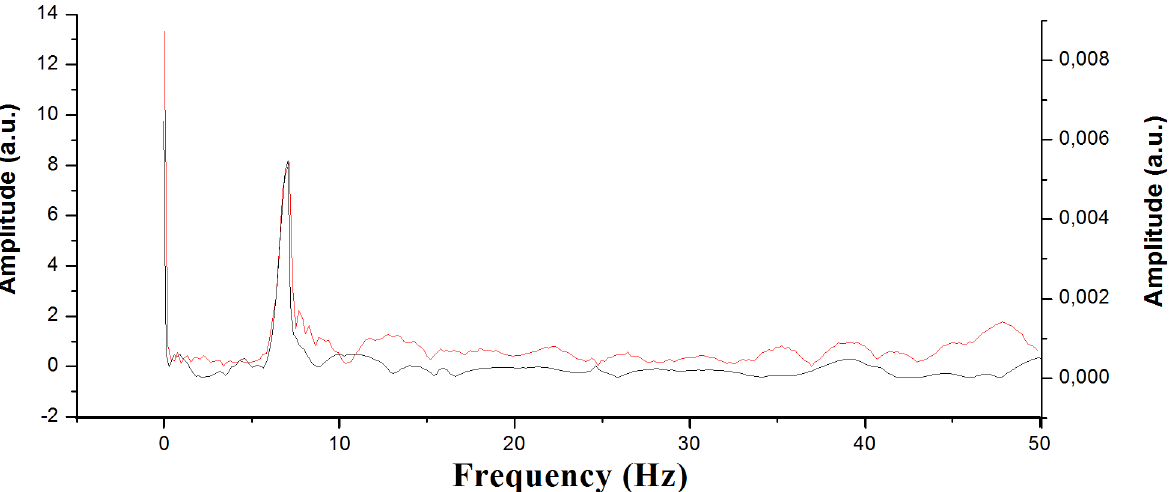
Figure 10. Fast-Fourier-Transform graph with the 100 Hz interrogator (red) and the 20 kHz interrogator (black).